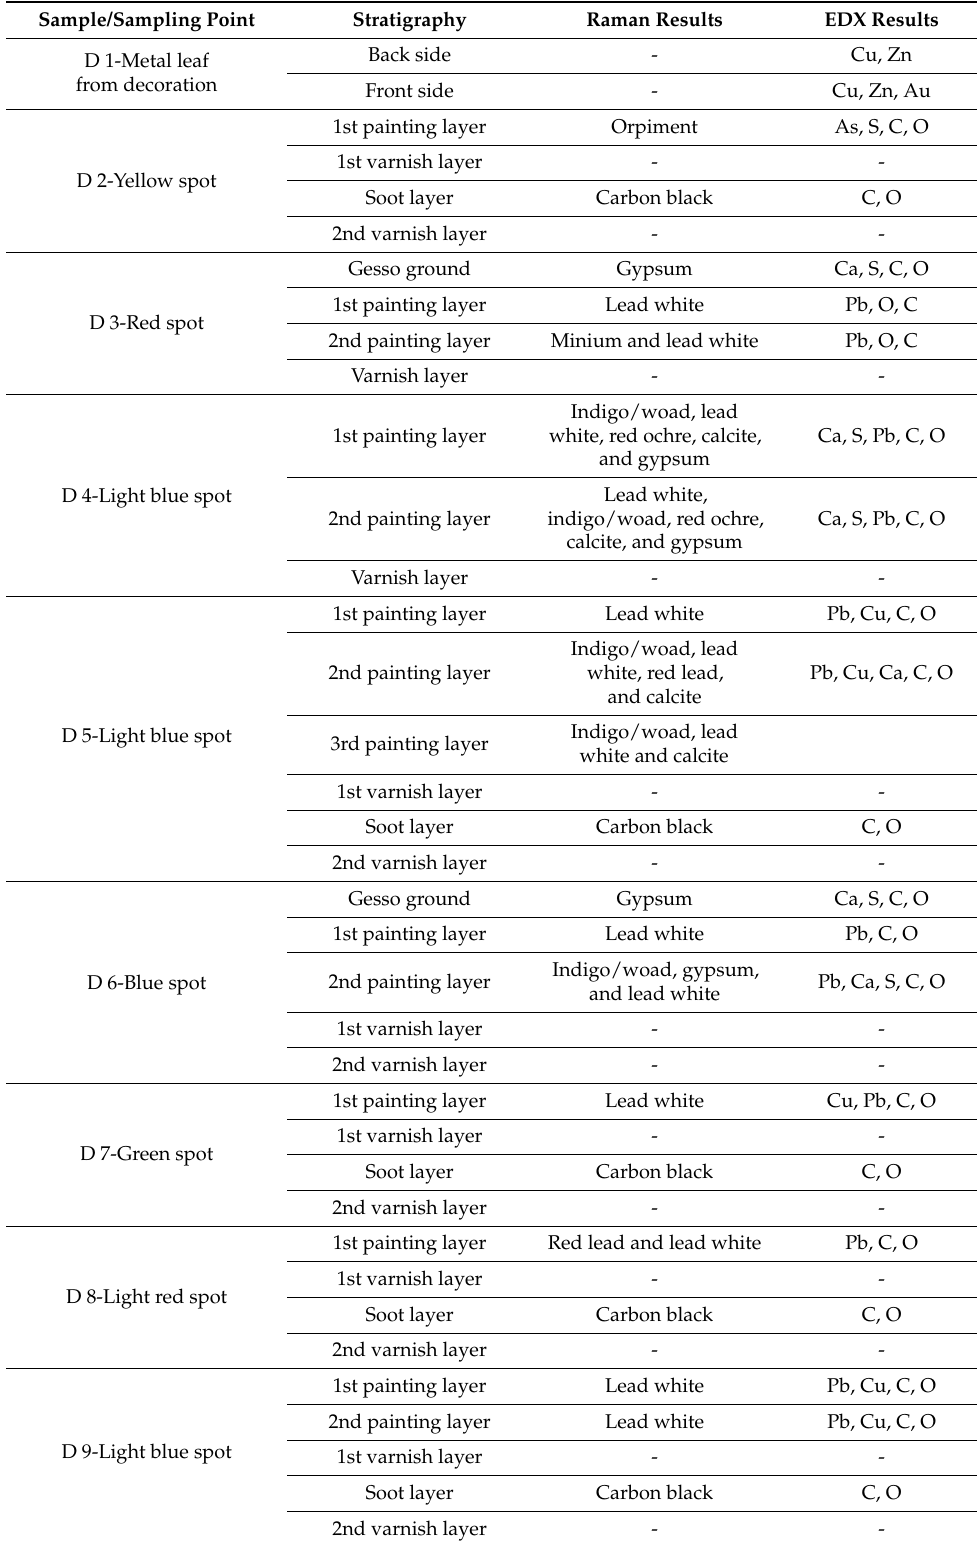
Table 1. Cross sections of the samples. Pigments were identified using micro-Raman spectroscopy and